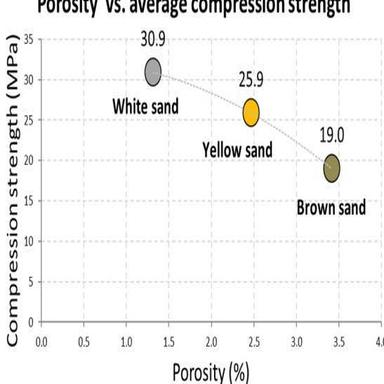
Porosity vs. average compressive strength.